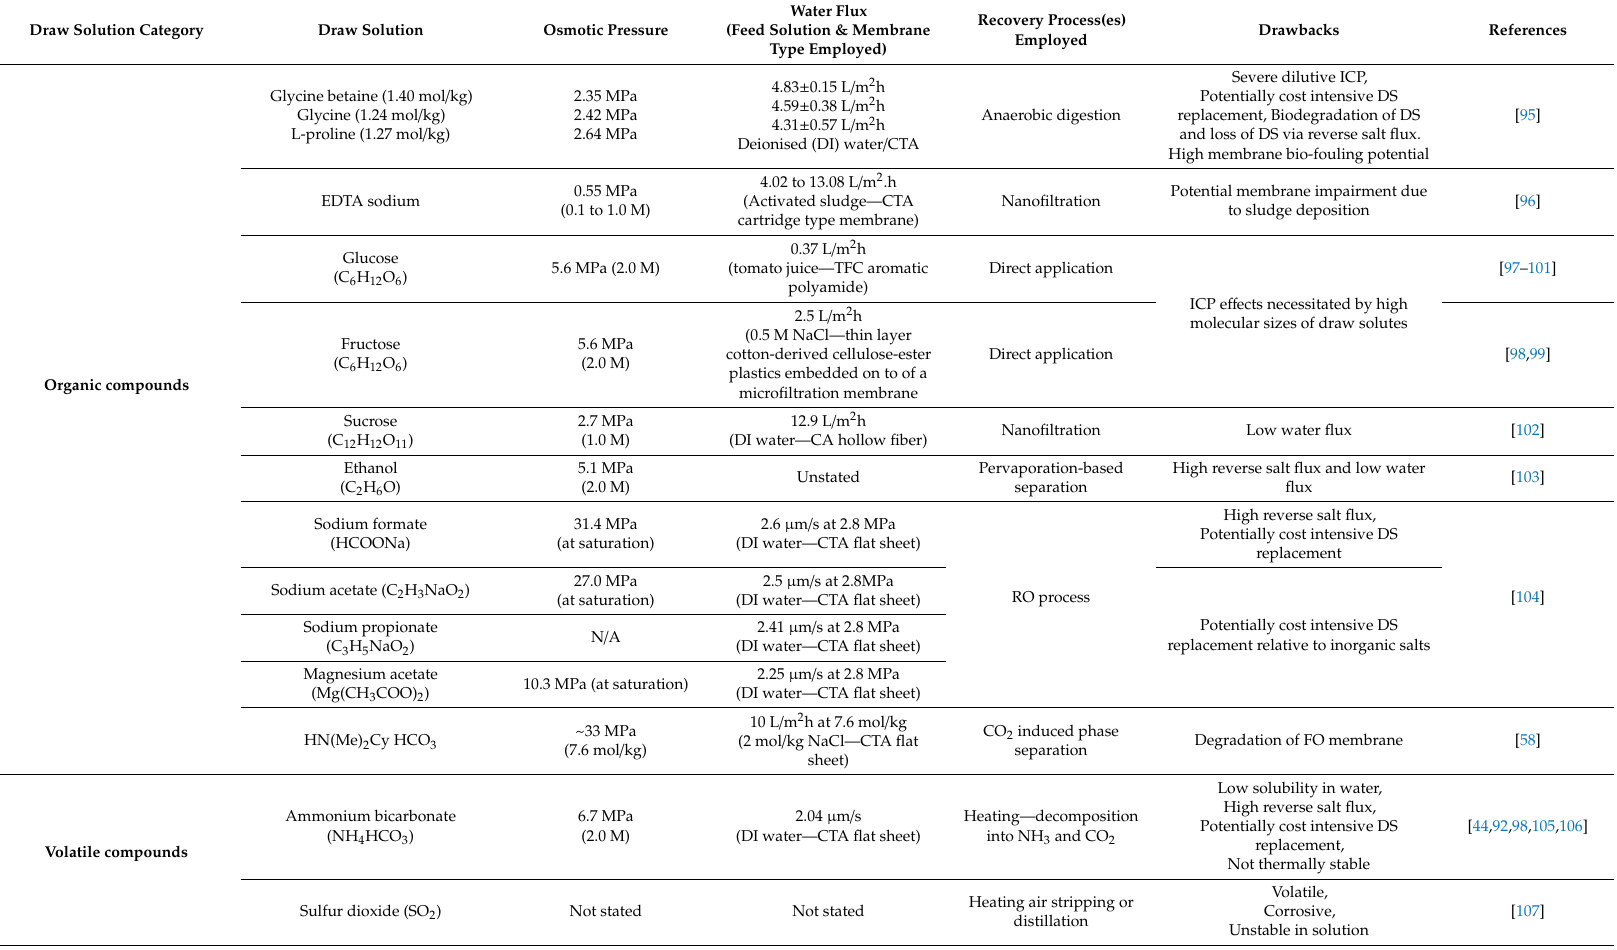
Table 4. Overview of the di ff erent draw solutions used in FO